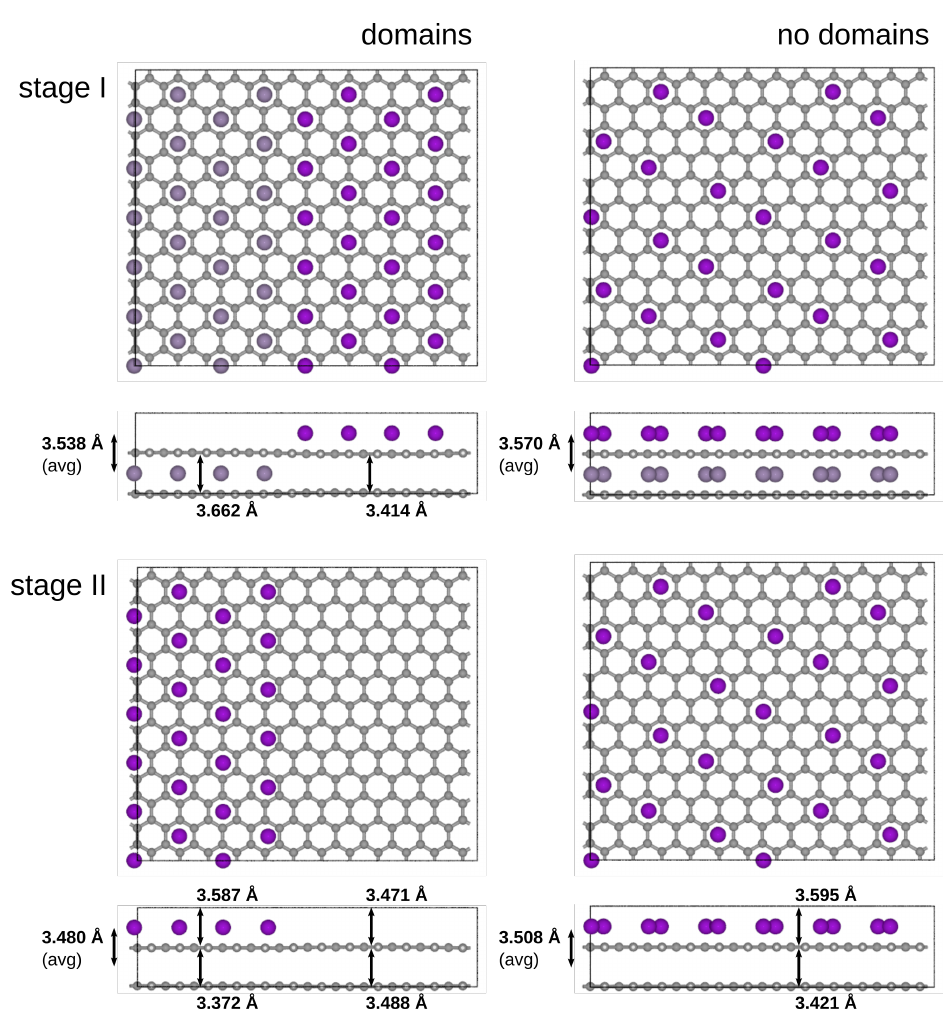
Figure 4. Top- and sideview of stage 1 and stage 2 domain-like and dilute Li-GIC configurations. Structures are fully relaxed, providing both overall average interlayer distances and local interlayer distances for filled and empty areas. For both stages, the domain-like structure has a smaller overall interlayer